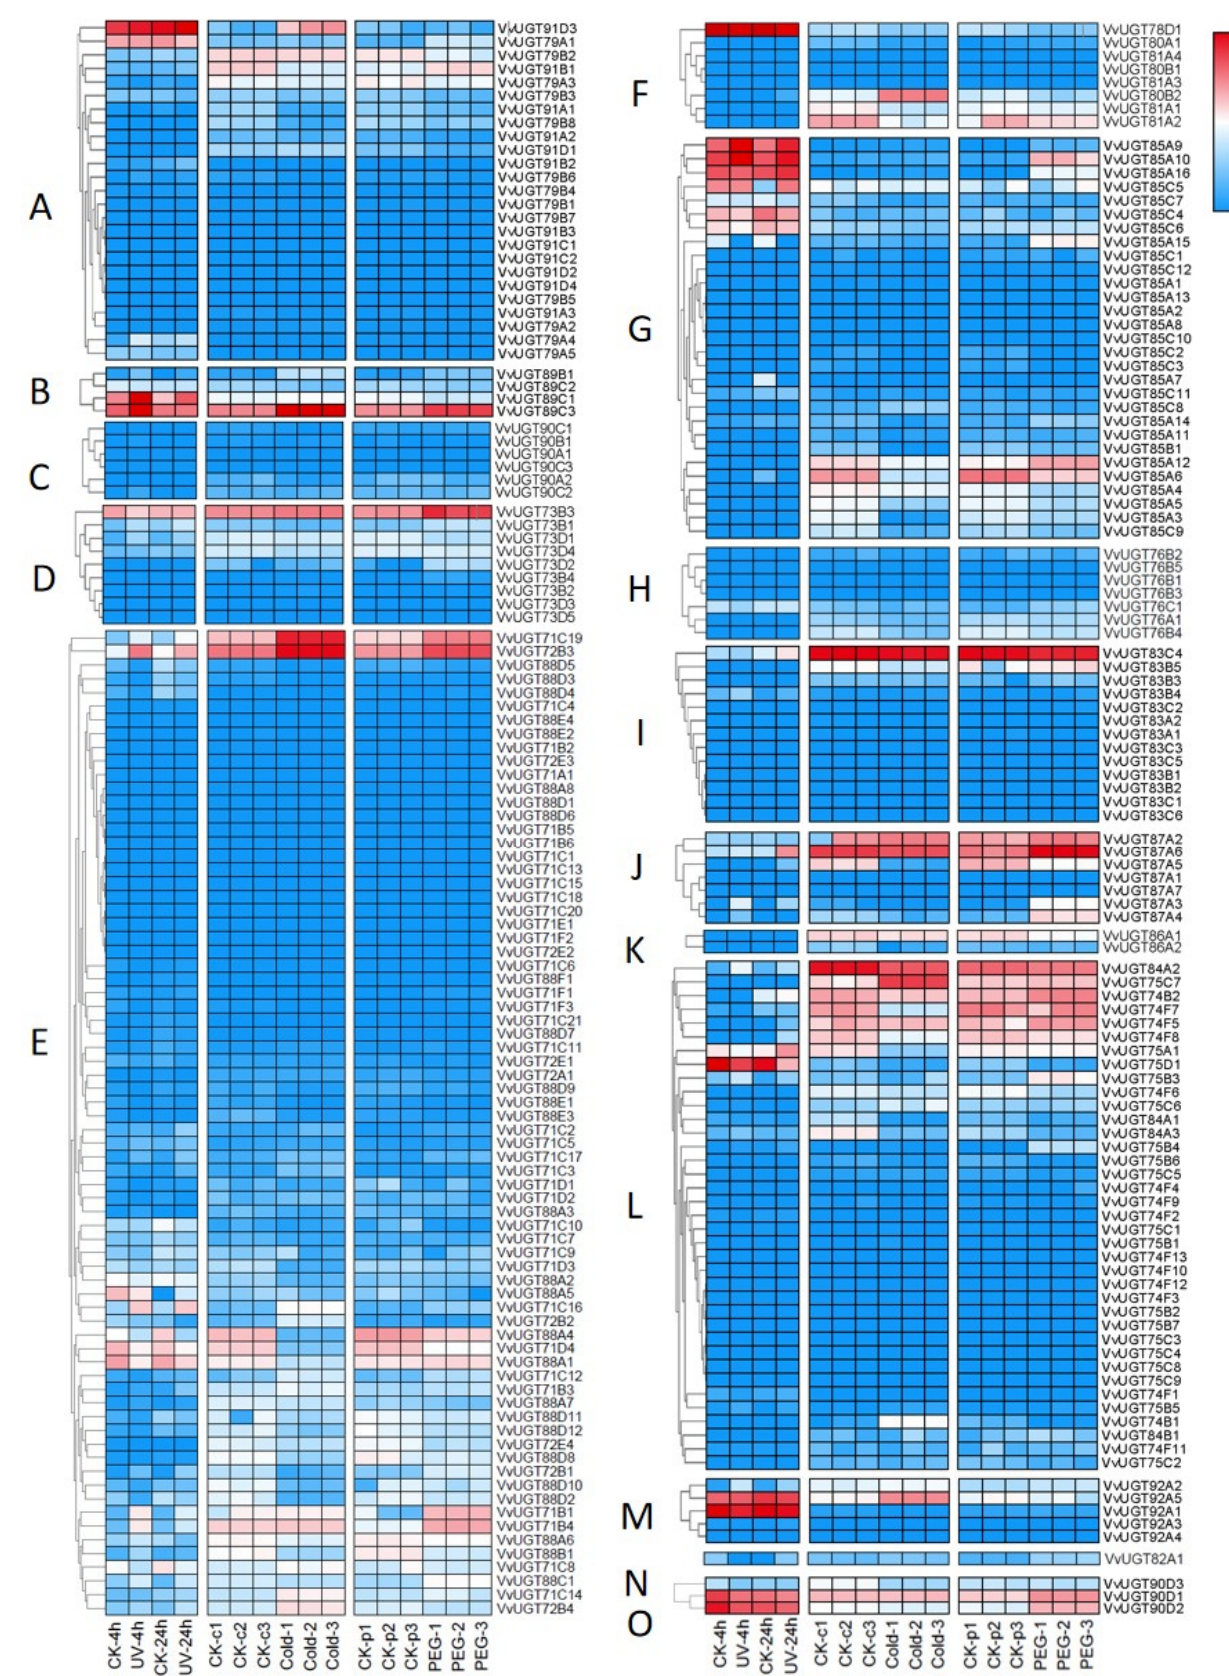
Figure 7. Expression profiles of UGT members in grapes in response to different abiotic stresses.